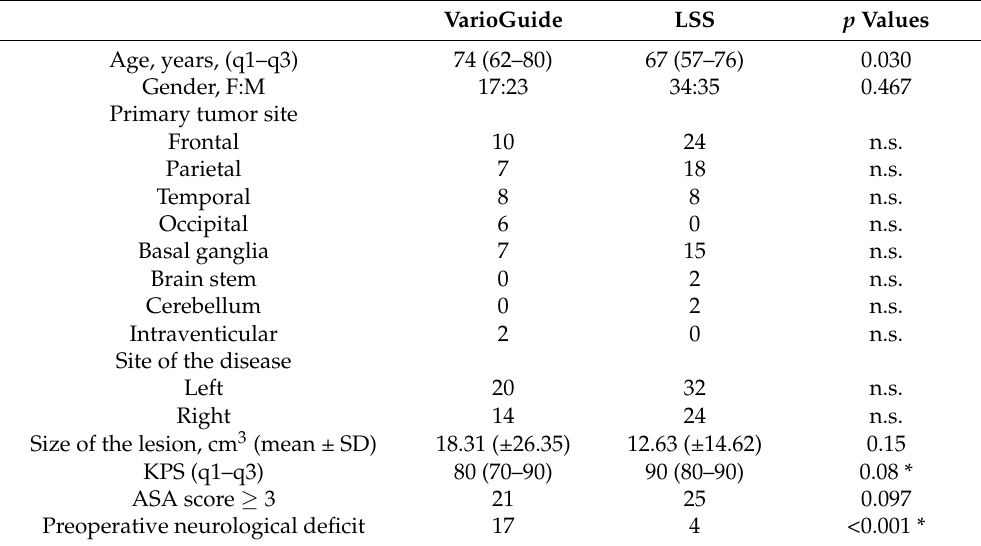
Table 1. Patient